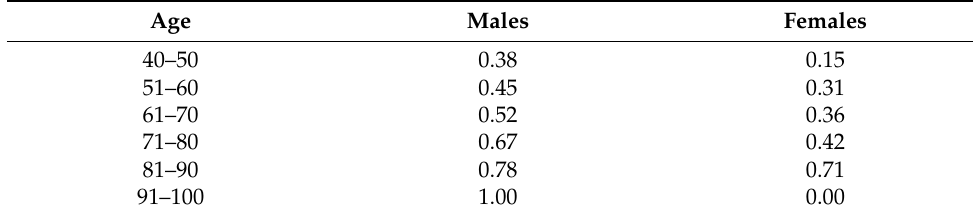
Table 3. Diagnostic rate based on individual characteristics.